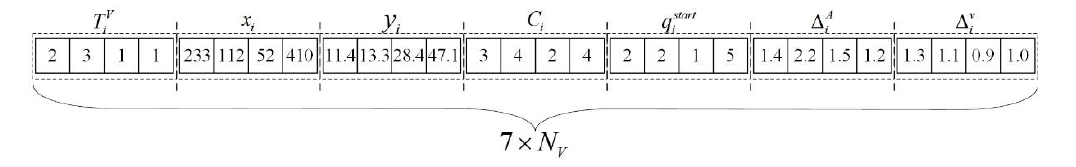
Figure 7. An example of the chromosome represented as a solution. (Source: compiled by